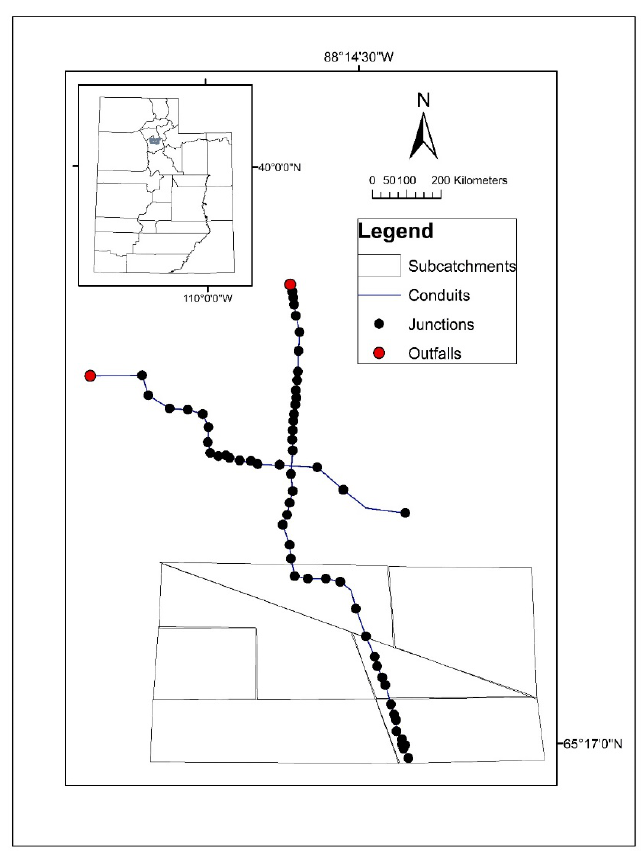
Figure 3. Study area located in the northern Utah state (left-top sub-figure: 1 degree roughly means 106 kilometer), the U.S. and the topological view of the stormwater urban drainage system model plotted by the PCSWMM v.7.3. (major sub-figure, scale unit is kilometer).